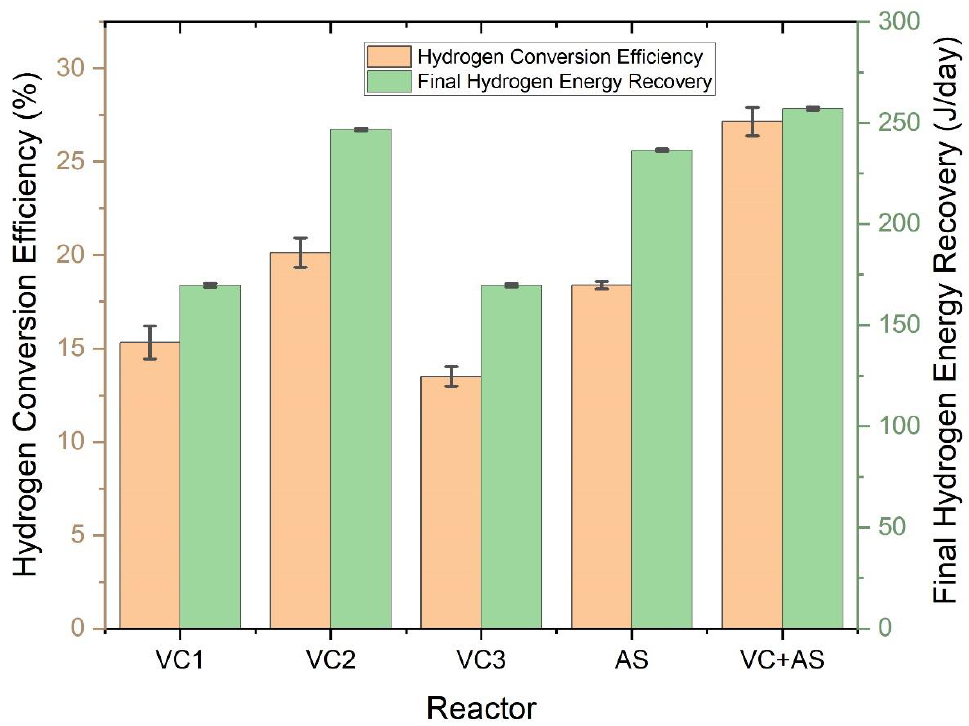
Figure 9. Hydrogen conversion efficiency and Energy recovery in different reactors.